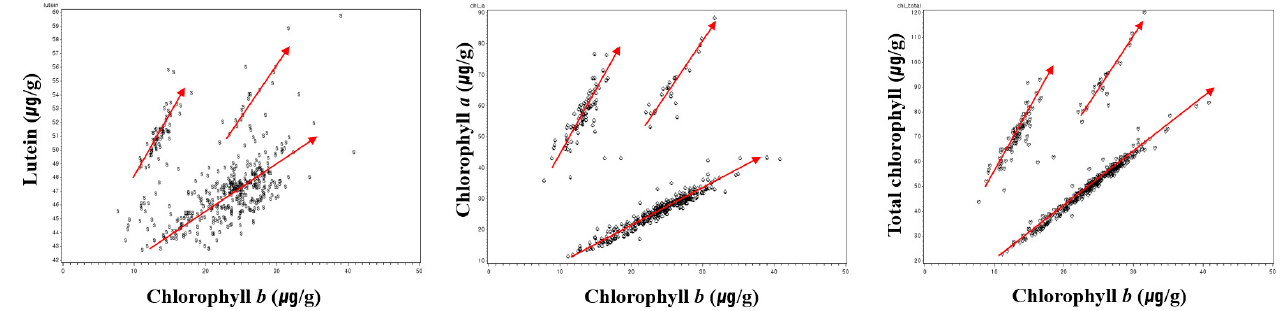
Figure 1. Scatterplots showing positive correlations between chlorophyll b and lutein, chlorophyll b and chlorophyll a , and chlorophyll b and total chlorophyll in 469 black soybean germplasms with green cotyledons, including check cultivars ‘Cheongja 3 ′ and ‘Cheongja’, over three years (2013–